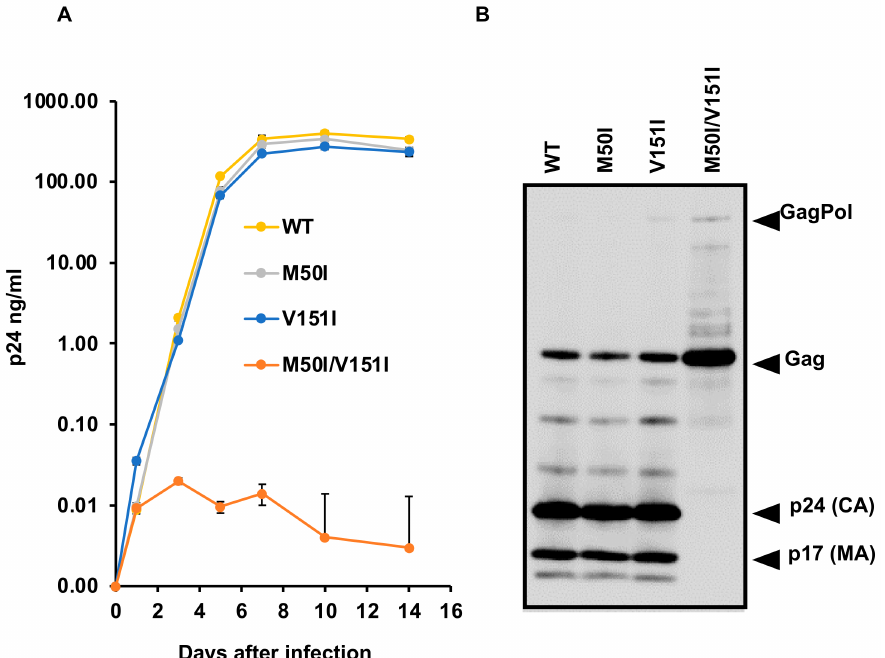
Figure 3. Characterization of IN:V151I Effect on HIV Replication: ( A ) Comparison of HIV replication